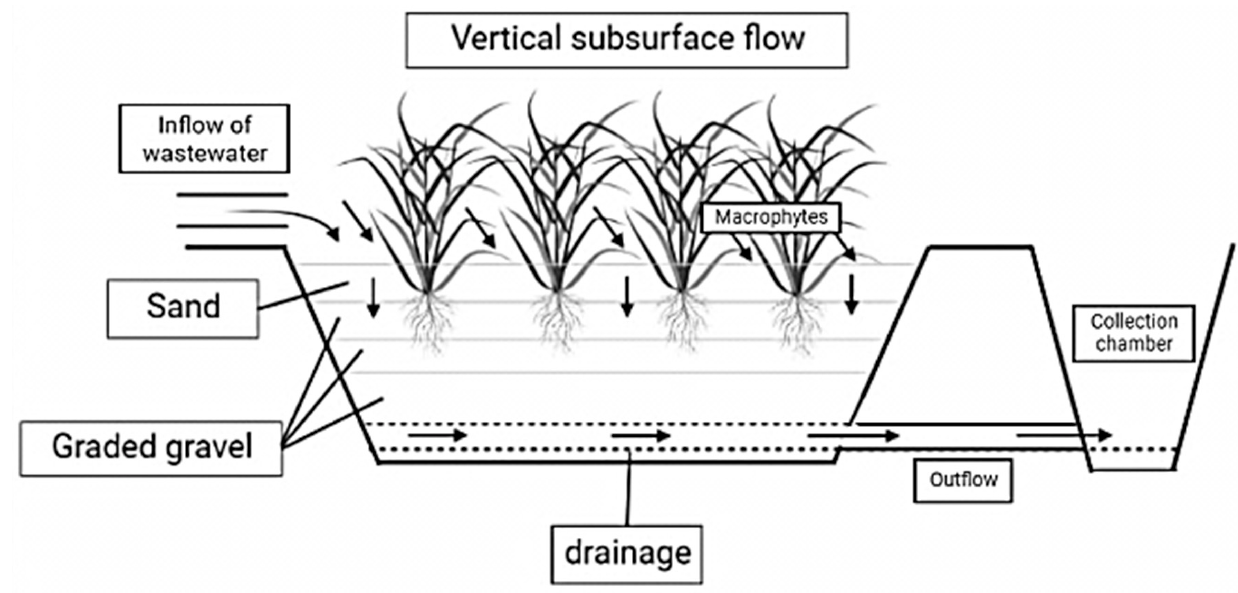
Figure 3. Vertical subsurface flow ‐ constructed wetland.